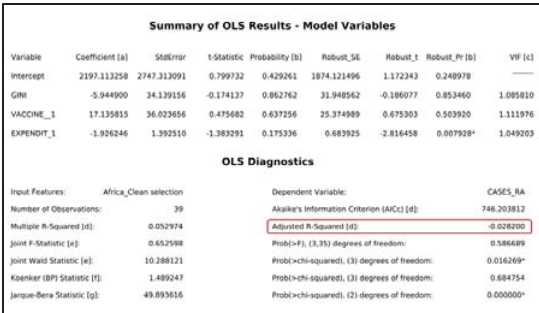
Figure 7. OLS results without